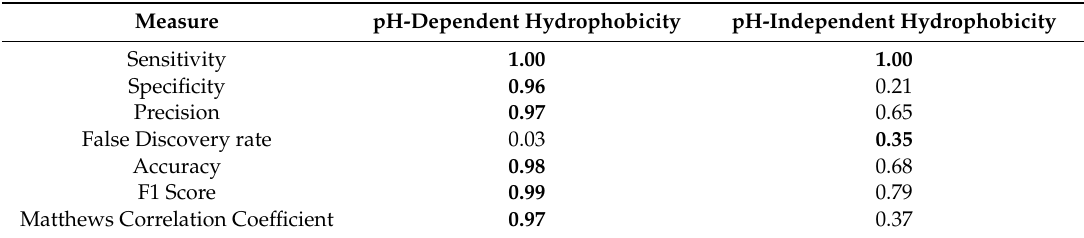
Performance of pH-dependent and pH-independent hydrophobicity approaches in predicting pH-conditioned order–disorder transitions in a C–H analysis by applying Equation (1). Unfolded sequences correctly predicted to be unfolded were classified as true positives. The highest values for each measure are indicated in